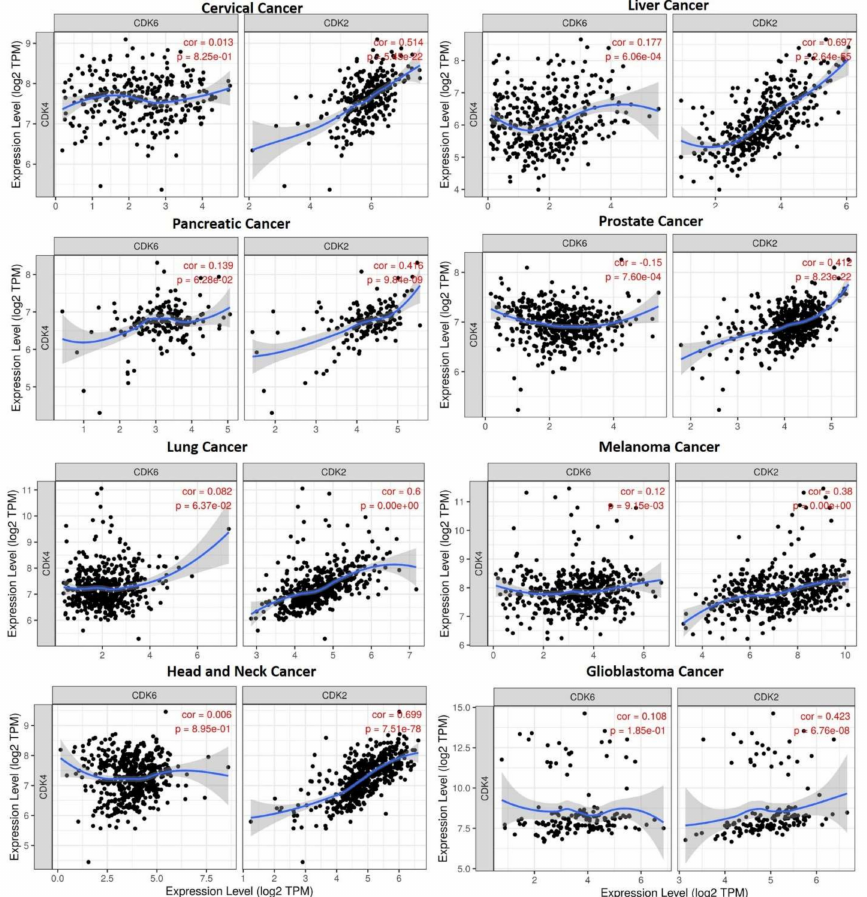
Figure 2. Expression scatterplots of CDK4 correlations with CDK2 and CDK6 in multiple cancer types. CDK4 expression was positively correlated with expressions of CDK2 and CDK6 in liver cancer, lung cancer, prostate cancer, pancreatic cancer, melanoma, head and neck cancer, glioblastomas, breast cancer, and cervical cancer cohorts ( r = 0.06~0.69). CDK4 was negatively correlated with CDK6 expression in prostate cancer ( r = − 0.5). The strength of correlations between the genes is reflected by the purity-adjusted partial spearman’s rho value and estimated statistical significance, where a value of r = 1 means a perfect positive correlation and a value of r = − 1 means a perfect negative